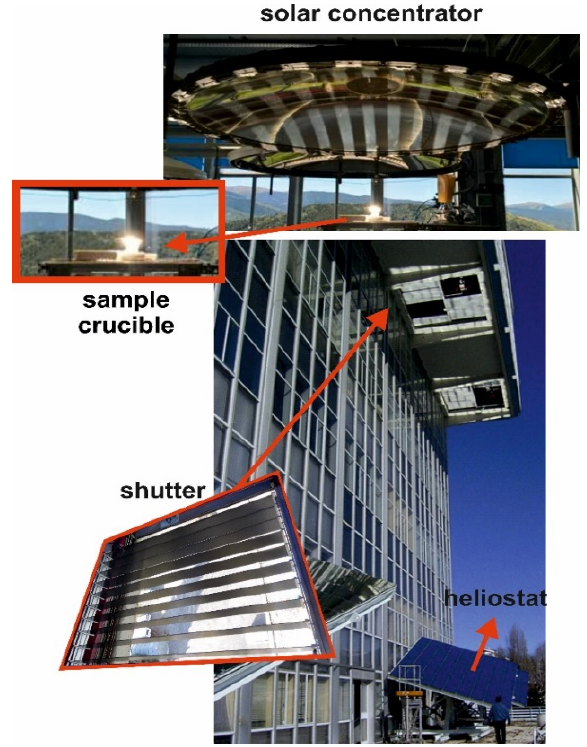
Figure 1. Solar energy facility (CNRS, Odeillo, France).